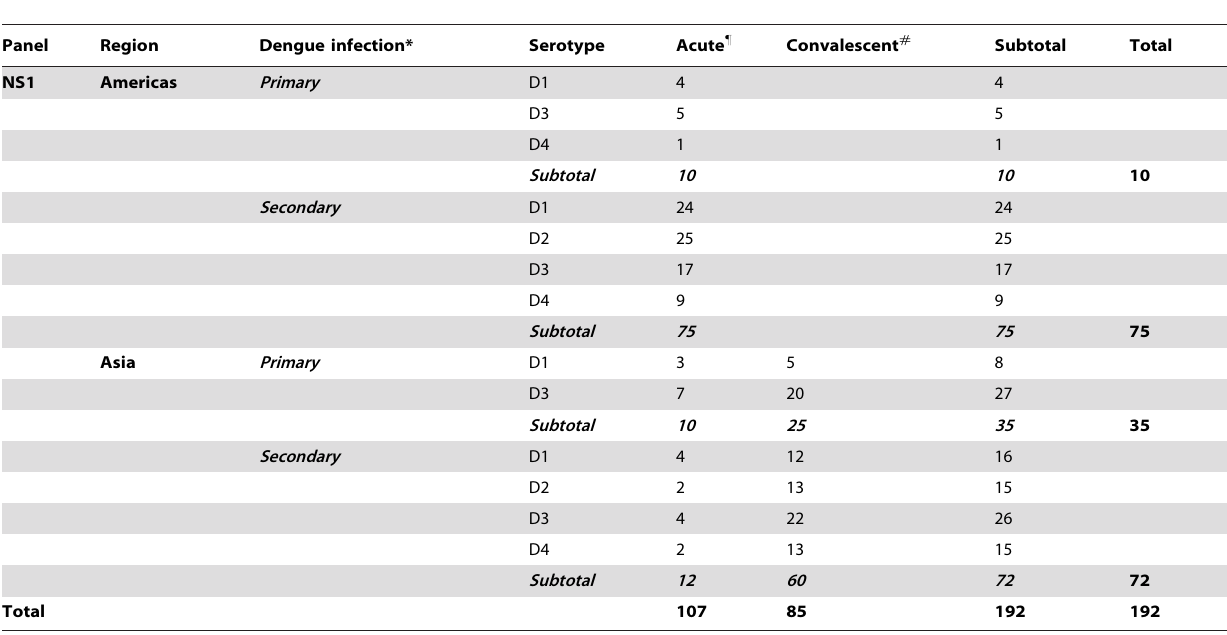
Table 1. Characteristics of specimens from dengue patients in the panel to evaluate dengue virus (DENV) non-structural protein 1 (NS1) detection kits.